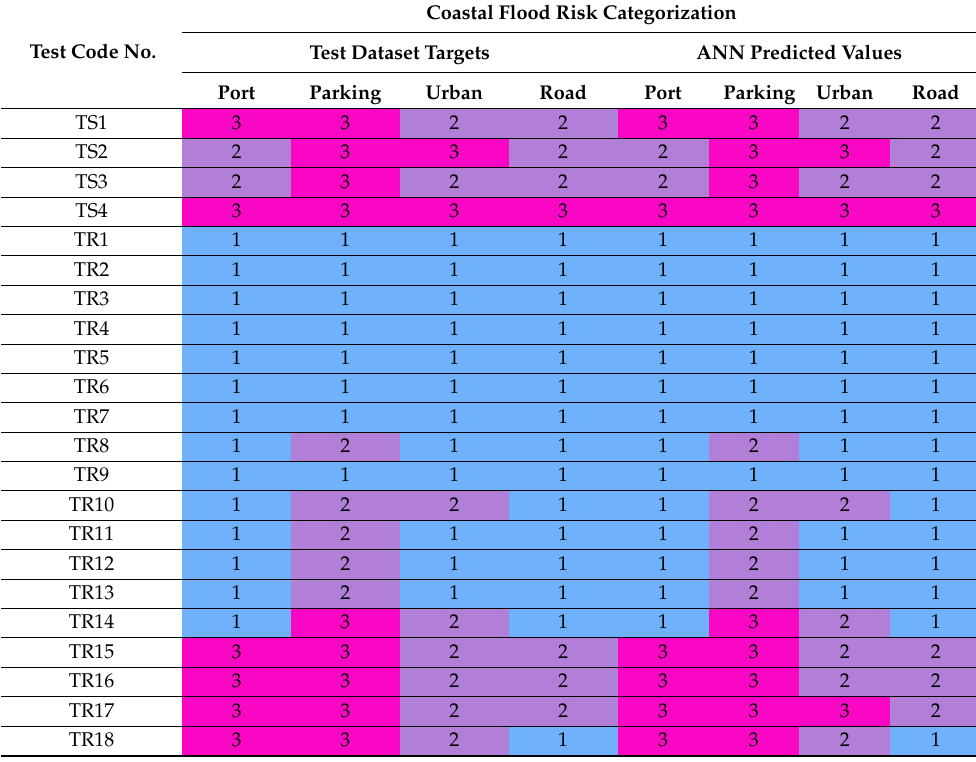
Table 4. ANN predictions of coastal flood-risk level for randomly selected sea-state events.